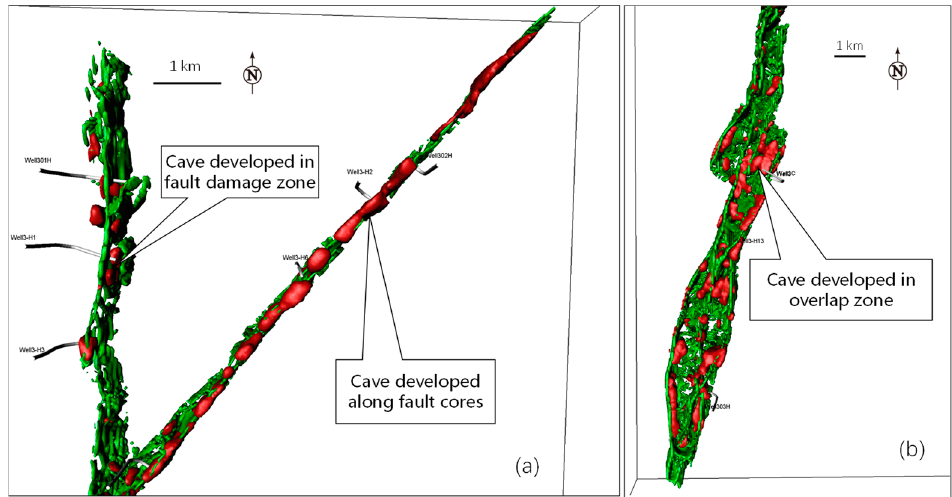
Figure 7. 3D fracture network overlapped with cave reservoirs of the northern segments ( a ) and southern segment ( b ) in well M1 area (the green blocks showing fracture network and the red blocks showing cave reservoirs).